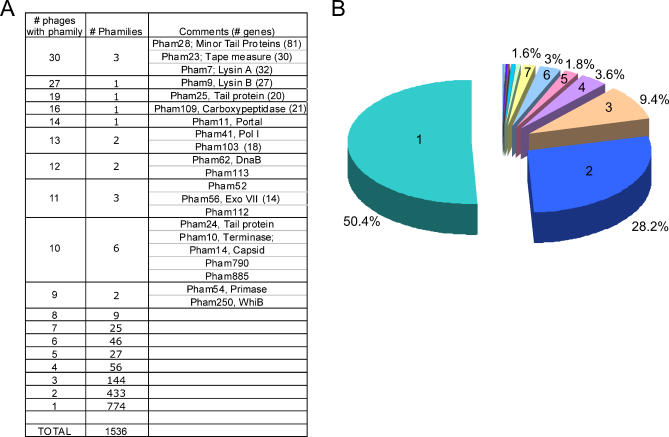
Size and Distribution of Mycobacteriophage PhamiliesAll 3,357 mycobacteriophage genes were assorted into 1,536 phamilies based on amino acid sequence similarity with a BLAST E value of 0.001 or better to at least one other member of the phamily.(A) The distribution of phamilies is shown ranked according to the number of mycobacteriophage genomes containing at least one phamily member. Examples of specific phams and the total number of mycobacteriophage genes within that pham are shown.(B) Pie-chart representation of the phamily-size distribution. Phamilies with eight or more members represent about 2% of the total.